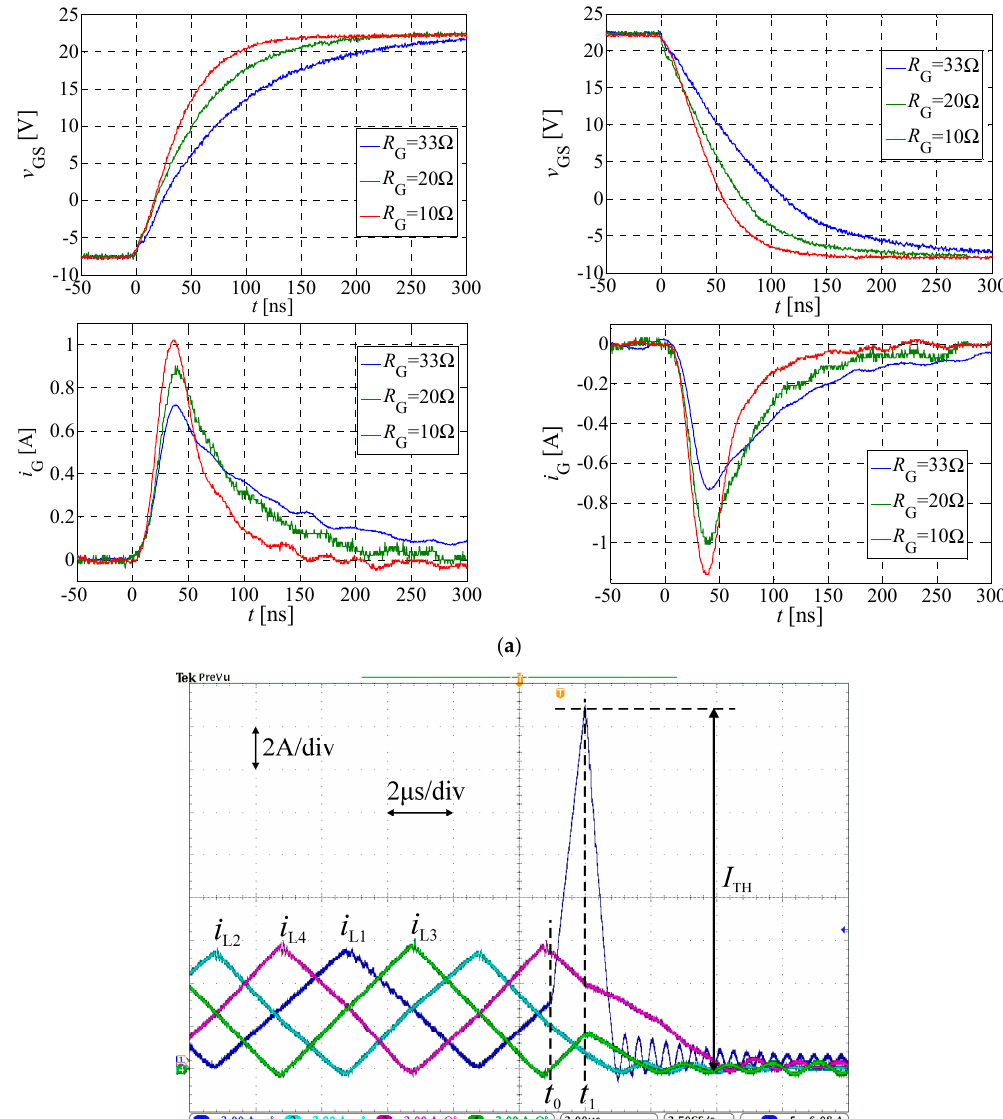
Figure 8. The gate driver for the interleaved DC-DC converter: ( a ) scheme and ( b ) photo of the prototype.